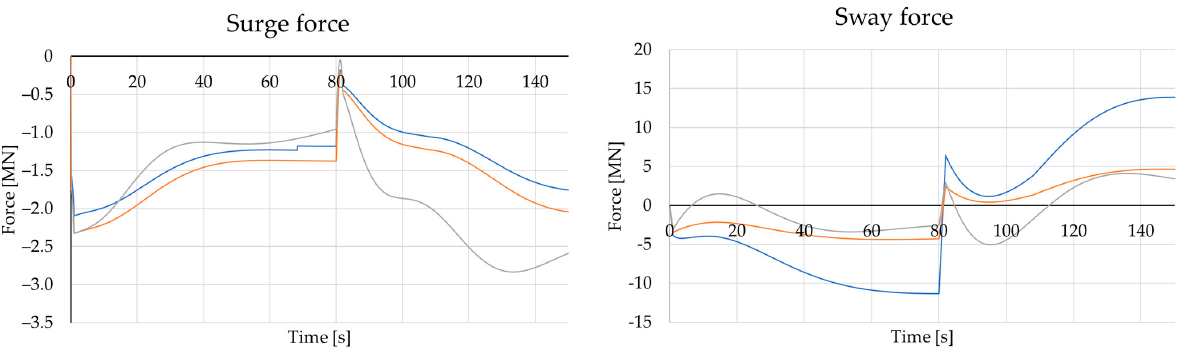
Figure 5. Half-turn simulation: ( a ) Input turning angle, ( b ) Comparison of displacement between results for three different Hydrodynamic Sets.